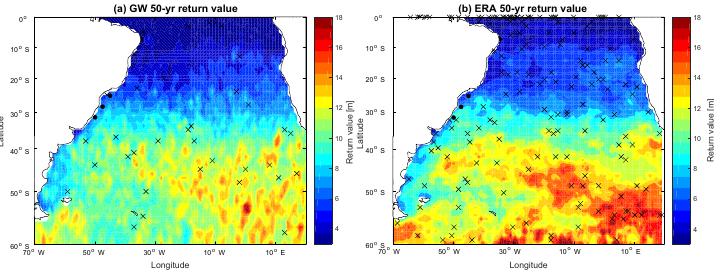
Figure 9. Distribution of 50-year return values from interpolated LOS data (a) and from ERA-Interim (b) in the South Atlantic. Crosses represent the series that did not pass the Kolmogorov–Smirnov